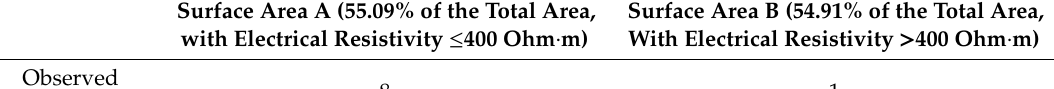
Table 2. Results of the chi-square test of independence of the windthrown plots occurrence on the soil electrical resistivity spatial distribution.